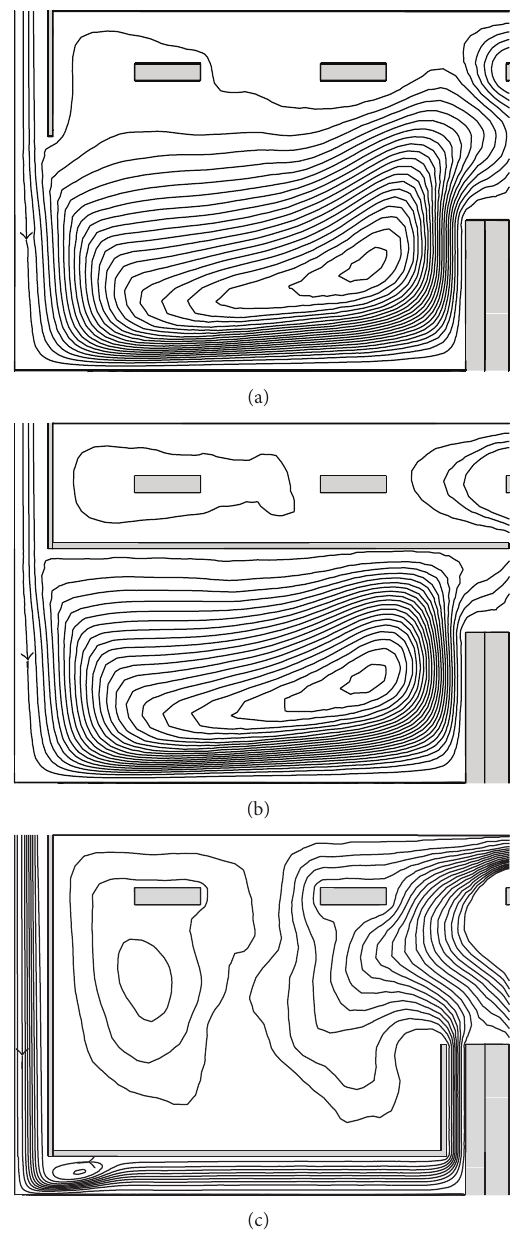
Figure 3: Stream lines above the melt free surface for different cover designs: (a) no cover, (b) flat cover, and (c) U